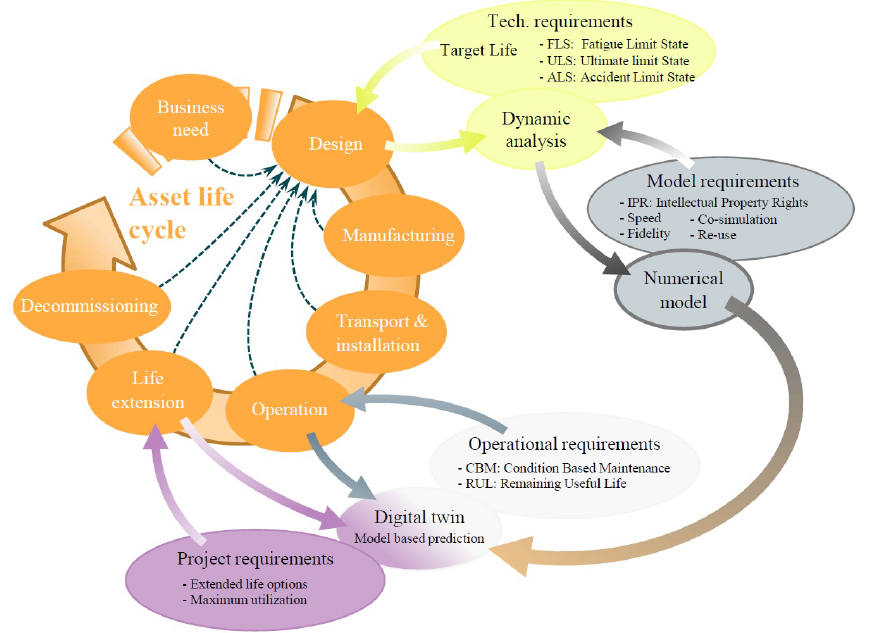
Figure 2. Wind turbine life cycle (Torsvik et al., 2018).